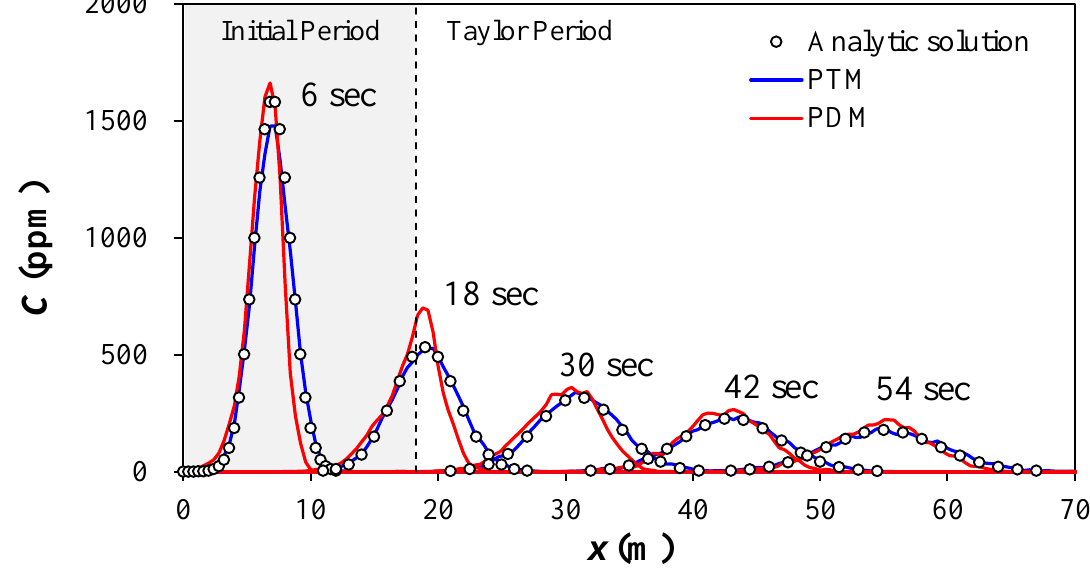
Figure4. Figure 4. Comparisons of concentration–distance curves of the PTM and the PDM in the straight channel.